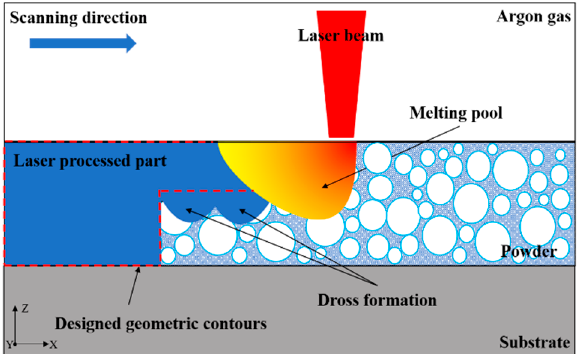
Figure 9. Schematic diagram of dross formation generation process.